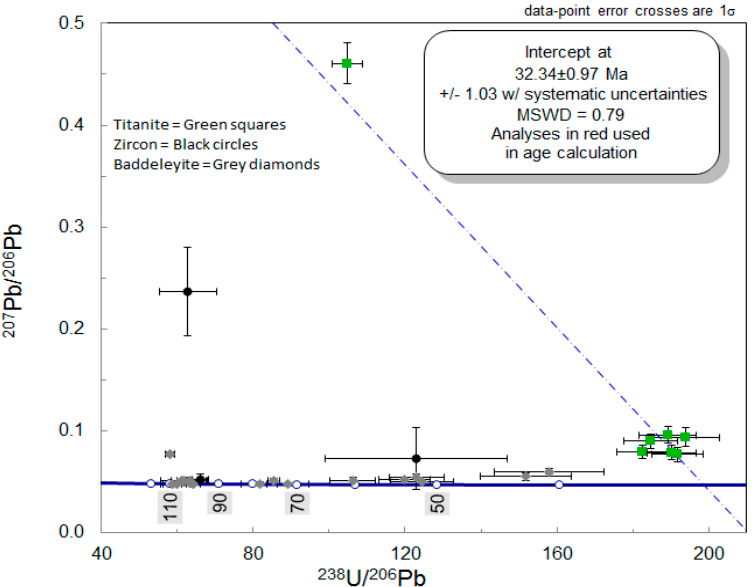
Figure 12. Concordia diagram showing titanite plots (green spots) and error bars constraining the intercept age of the titanite composite inclusion in Thurein Taung ruby. Comparative age plots are shown for older zircon included ruby (grey) and baddeleyite megacrysts (black) from Thurein Taung.